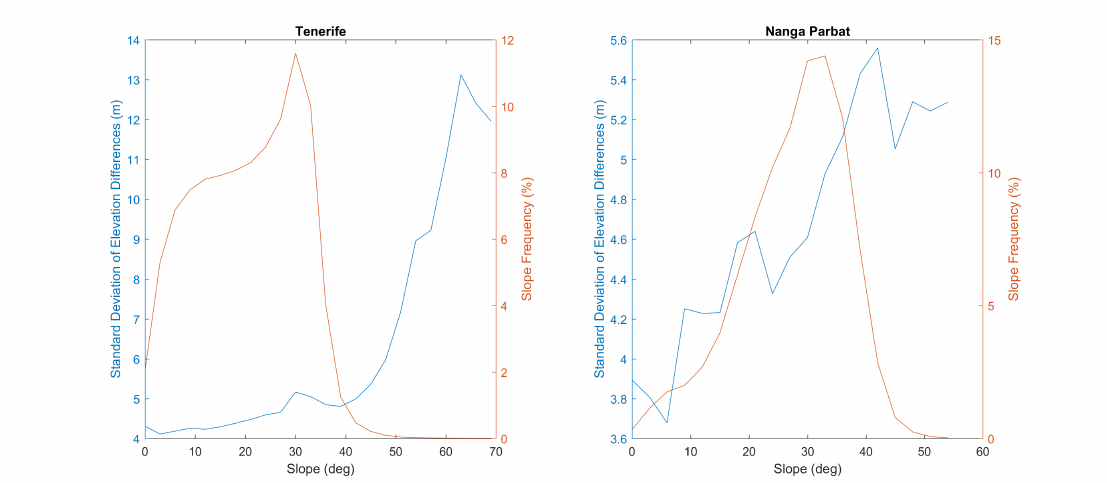
Figure 19. The variation in the standard deviation of elevation differences versus the slope of the DEM for Tenerife and stable terrain of Nanga Parbat.